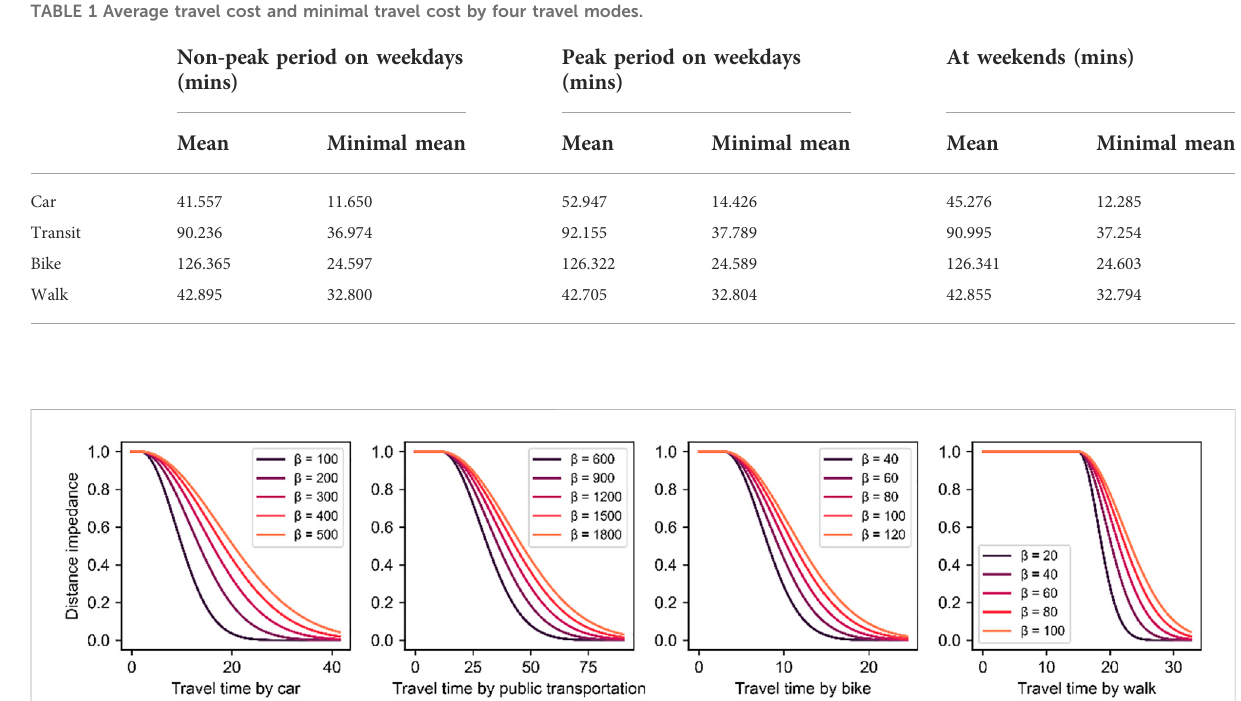
TABLE 1 Average travel cost and minimal travel cost by four travel modes.